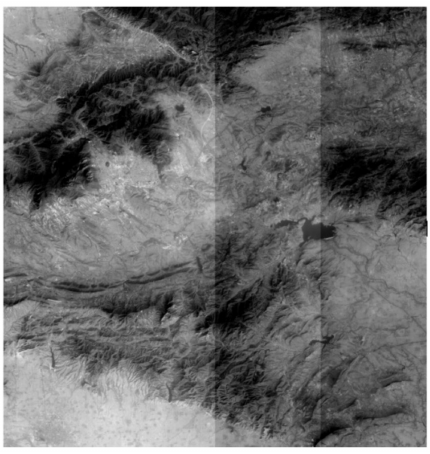
Figure 9. Mosaic image for the 4 TDICCD chips in the forward view.